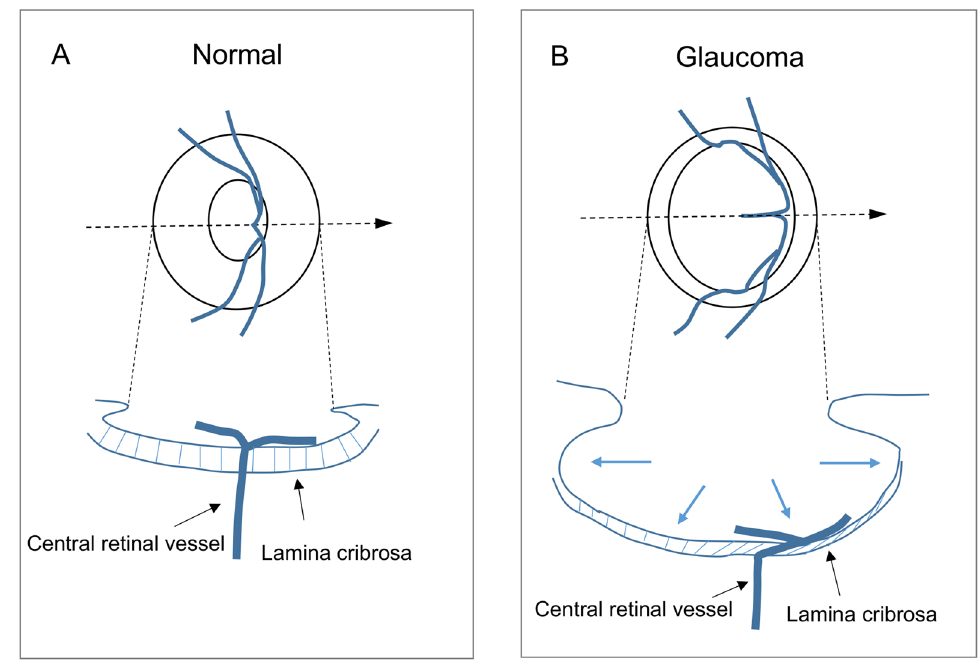
Figure 5. Scheme of the mechanism behind the nasal displacement of the central retinal vessel on the optic nerve head in eyes with